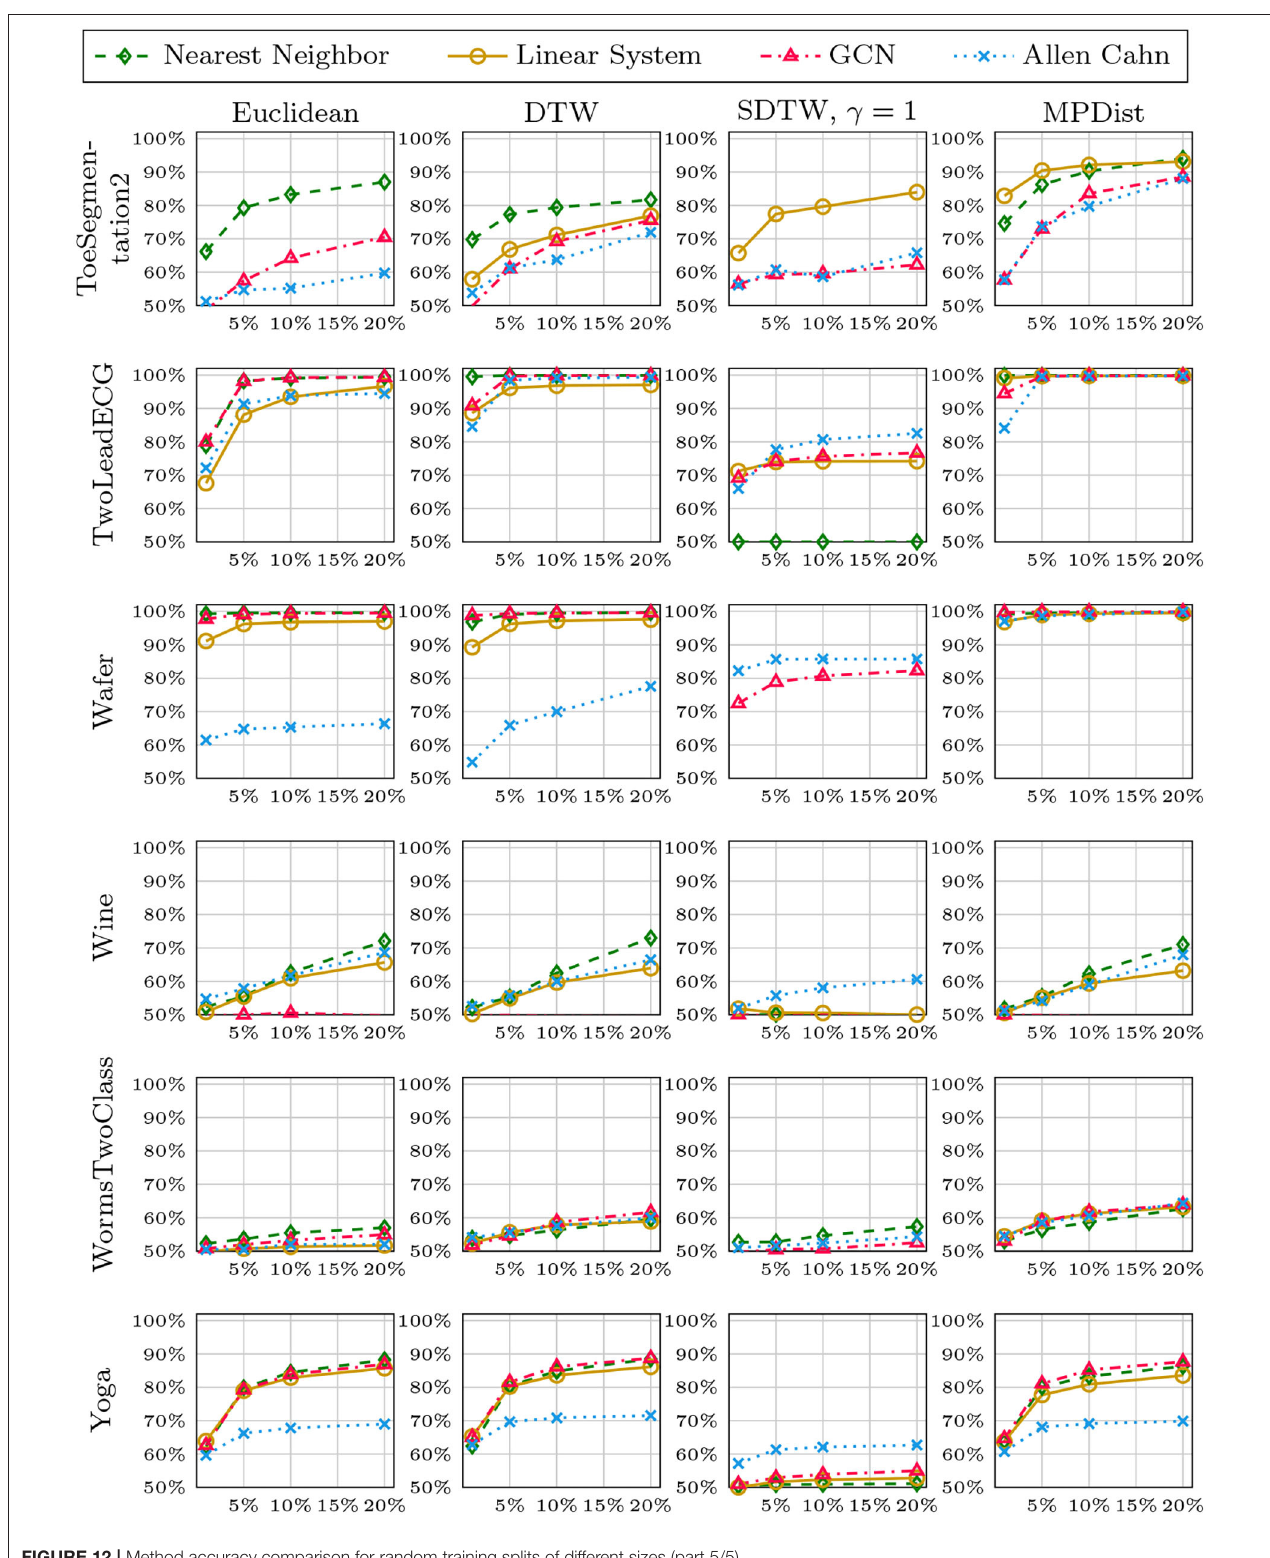
FIGURE 12 | Method accuracy comparison for random training splits of different sizes (part